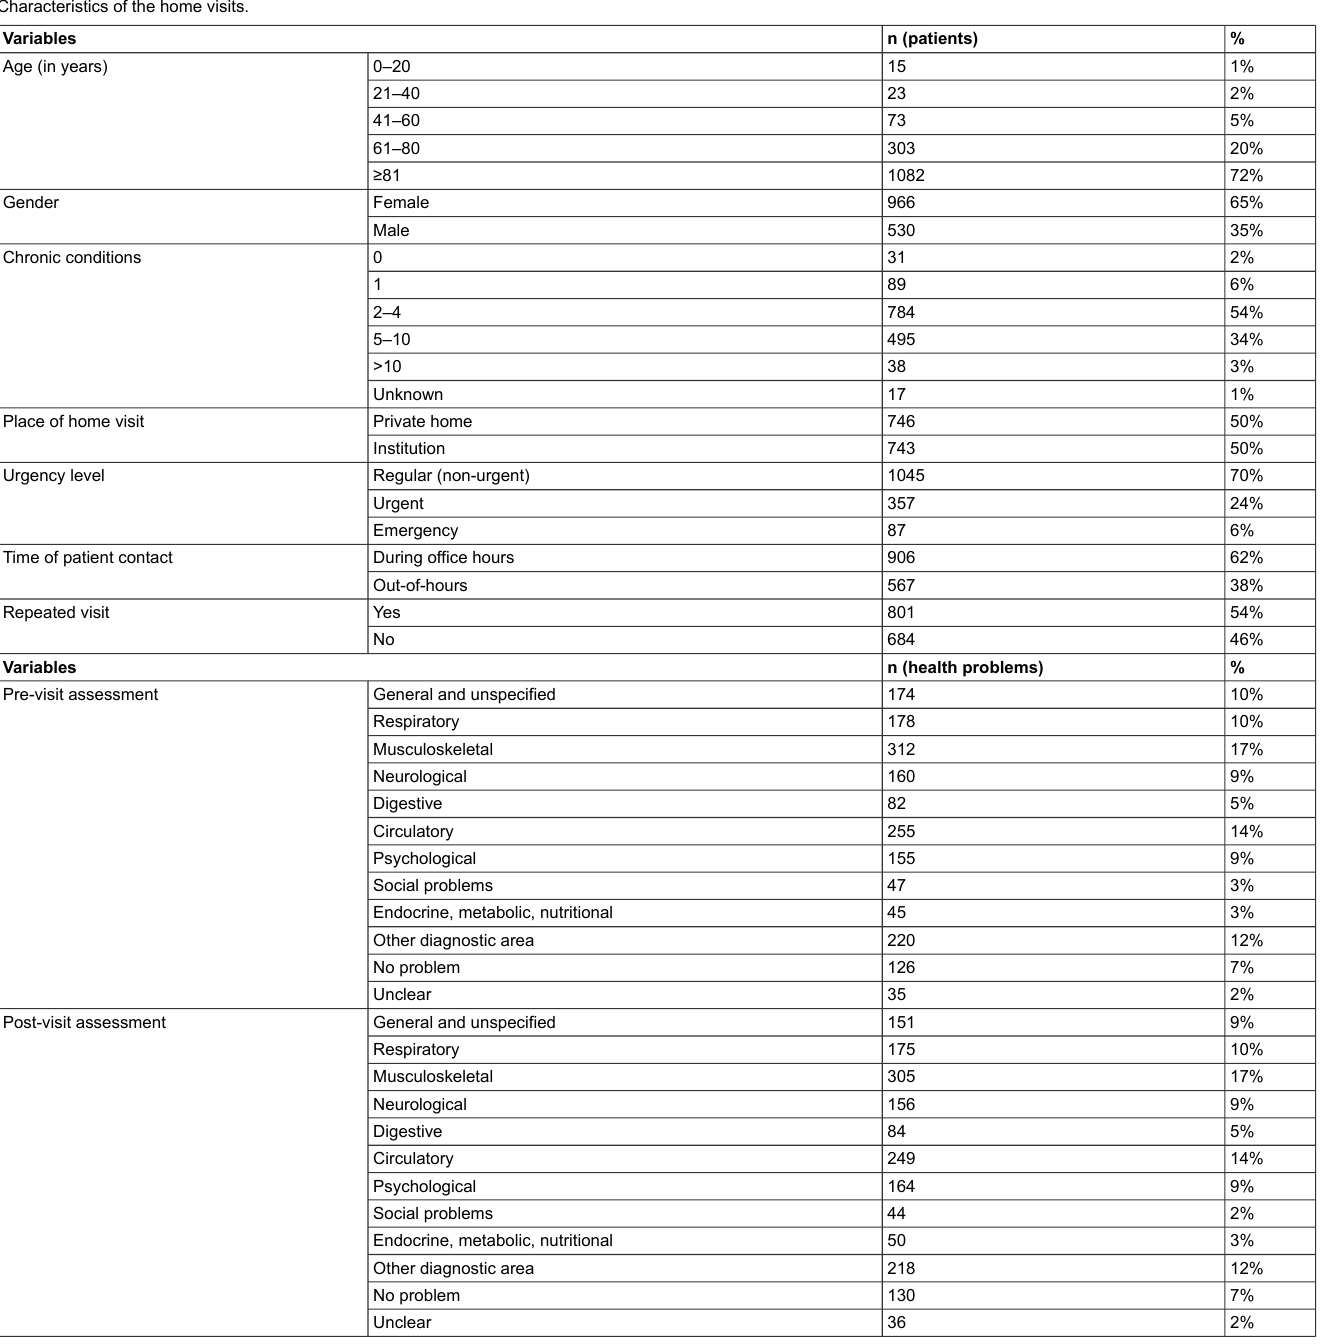
Table 1: Characteristics of the home visits.